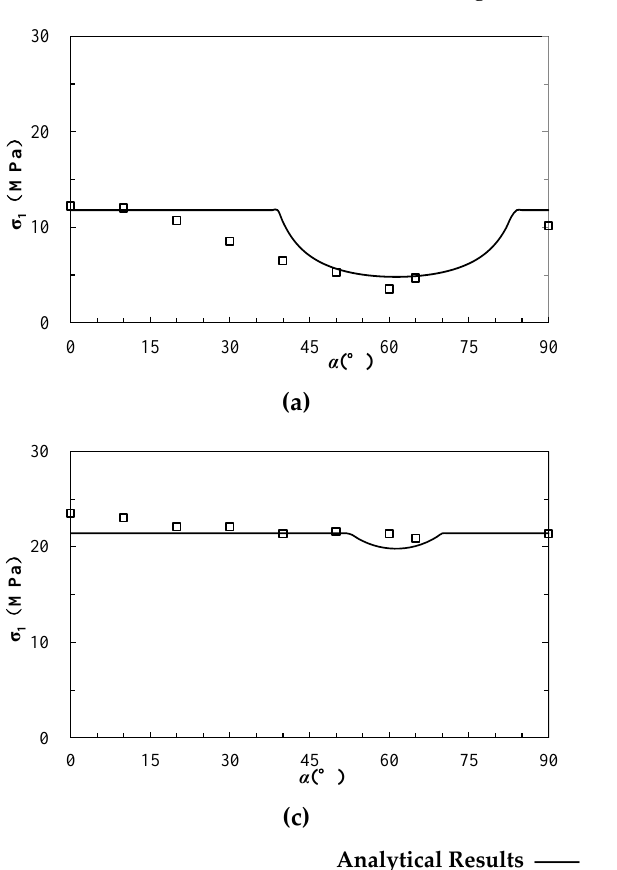
different confining levels.